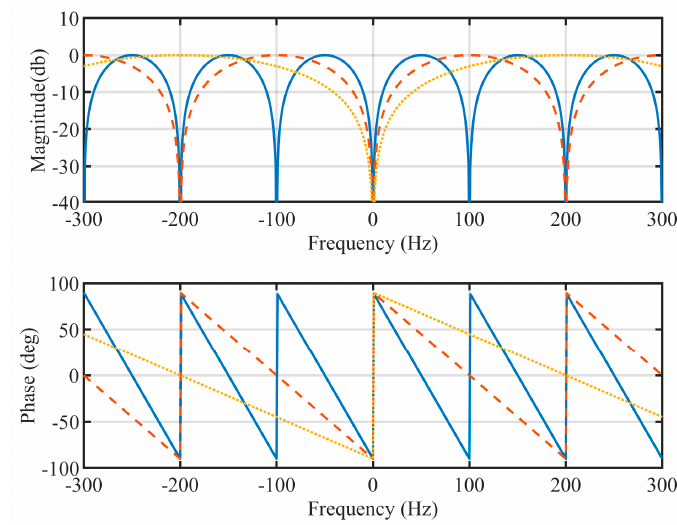
Figure 7. The frequency characteristic of MDSCs with different n ( m =2).